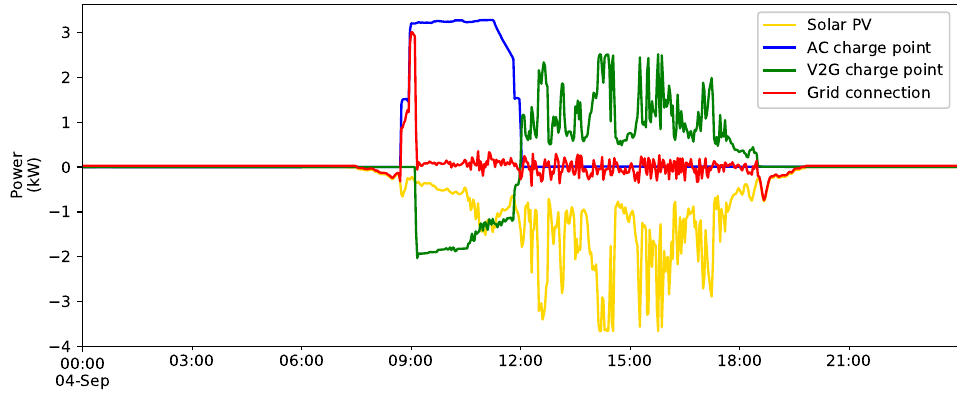
Figure A1. Operation of the V2G setup at the Green Village on 4 September